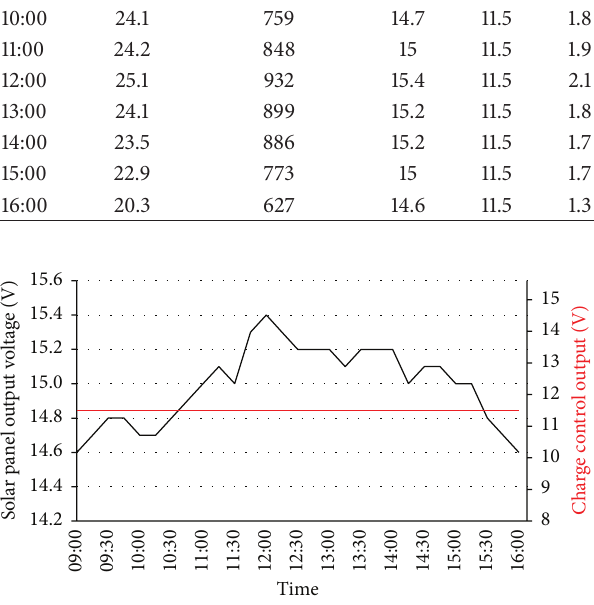
Figure 9: Change in solar panel and charge control output voltages during charge of